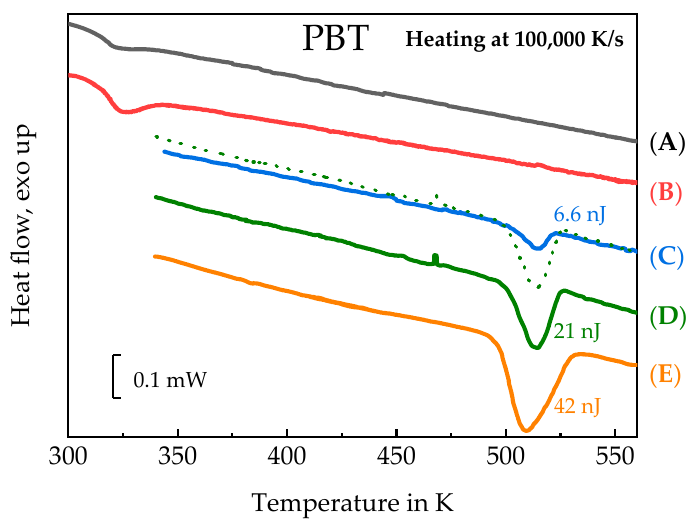
Figure 16. FSC melting curves at heating rate of 100,000 K / s. ( A )—Quenched sample. ( B )—Annealing at 290 K for 10,000 s. ( C )—Annealing at 490 K for 1 s. ( D )—Annealing at 290 K for 10,000 s followed by a development stage at 490 K for 1 s. ( E )—Annealing at 490 K for 10,000 s (The dotted curve overlaid on curve ( C ) is the duplication of curve ( D ) for comparison).